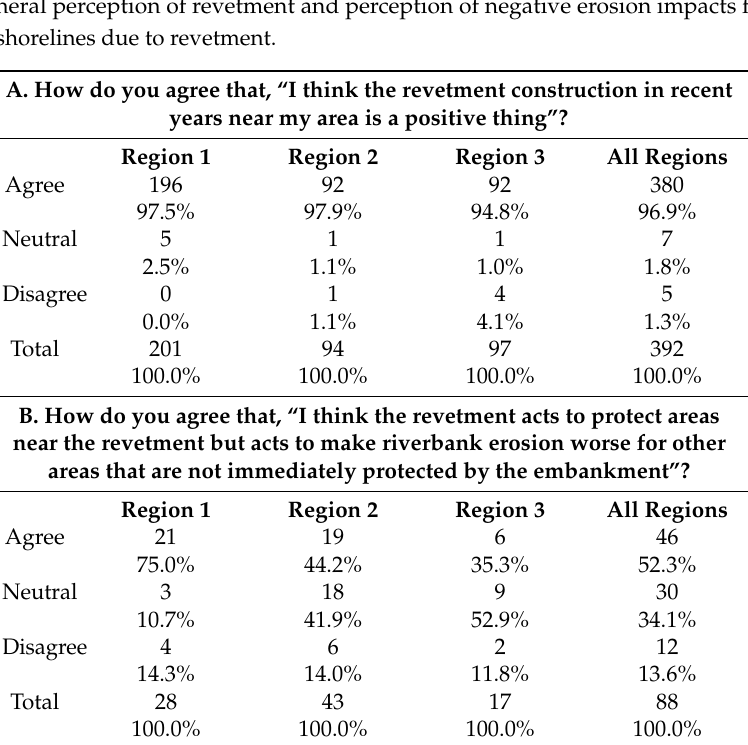
Table 13. General perception of revetment and perception of negative erosion impacts for proximal unprotected shorelines due to